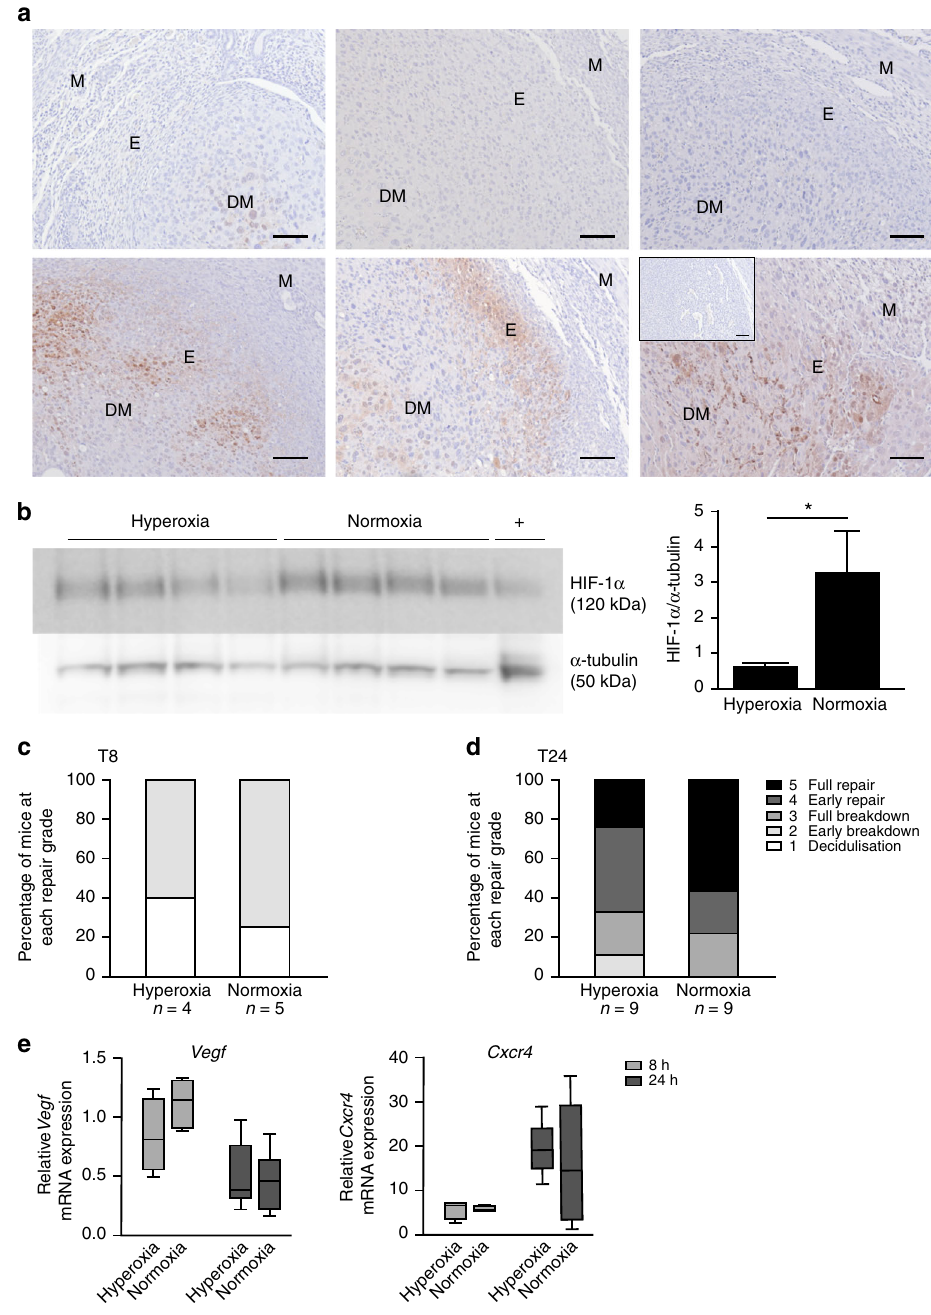
Fig. 3 Non-hypoxic menstruation decreases endometrial HIF-1 α and delays endometrial repair. a Pimonidazole staining in endometrium at T8 from three mice placed in hyperoxic (75% O2, top panel) and three mice in normoxic (21% O2, bottom panel) conditions at the time of progesterone withdrawal. M myometrium, DM decidualised mass, E endometrium. Inset = negative control. Scale bar = 100 μ m. b HIF-1 α western blot of uterine protein extracts at T8 from mice in 75% O2 (hyperoxia = non-hypoxic endometrium) versus 21% O2 (normoxia = hypoxic endometrium) with densitometry. * P < 0.05, unpaired t -test. c Endometrial histological breakdown/repair score at T8 in mice incubated in hyperoxic and normoxic conditions. Graphs represent percentage of mice at each histological grade per experimental group. White — decidualisation, light grey — early breakdown, medium grey — full breakdown, dark grey — early repair, black — full repair (Supplementary Fig. 2). d Endometrial histological breakdown/repair score at T24 in mice placed in hyperoxic and normoxic conditions. Graphs represent percentage of mice at each histological grade per experimental group. e Vegf and Cxcr4 concentrations in mouse uterine tissue at T8 and T24 in mice incubated in normoxia and hyperoxia. Box and whisker plots: box represents upper and lower quartiles with horizontal line representing the median, whiskers represent minimum and maximum